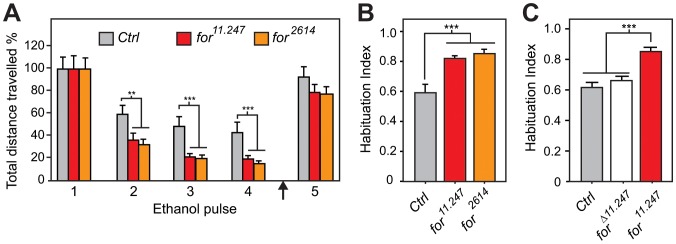

for alleles enhance olfactory startle habituation.
A)
for11.247 and for2614 show enhanced OSH. A reduction of distance traveled (compared to Ctrl) was seen in both alleles at pulse 2 (p<0.01), 3 and 4 (p<0.001;(n = 12). B)
for11.247 and for2614 have an enhanced HI (indicating more habituation). Significant difference was seen between Ctrl and for11.247 or for2614 (p<0.001; n = 12). C) Compared to Ctrl, the precise excision, forΔ11.247, had a normal HI (p>0.05; n = 6). Unless indicated, significance was established by a One-Way-ANOVA with post-hoc Newmans-Keuls tests in all figures (*p<0.05, **p<0.01, ***p<0.001).